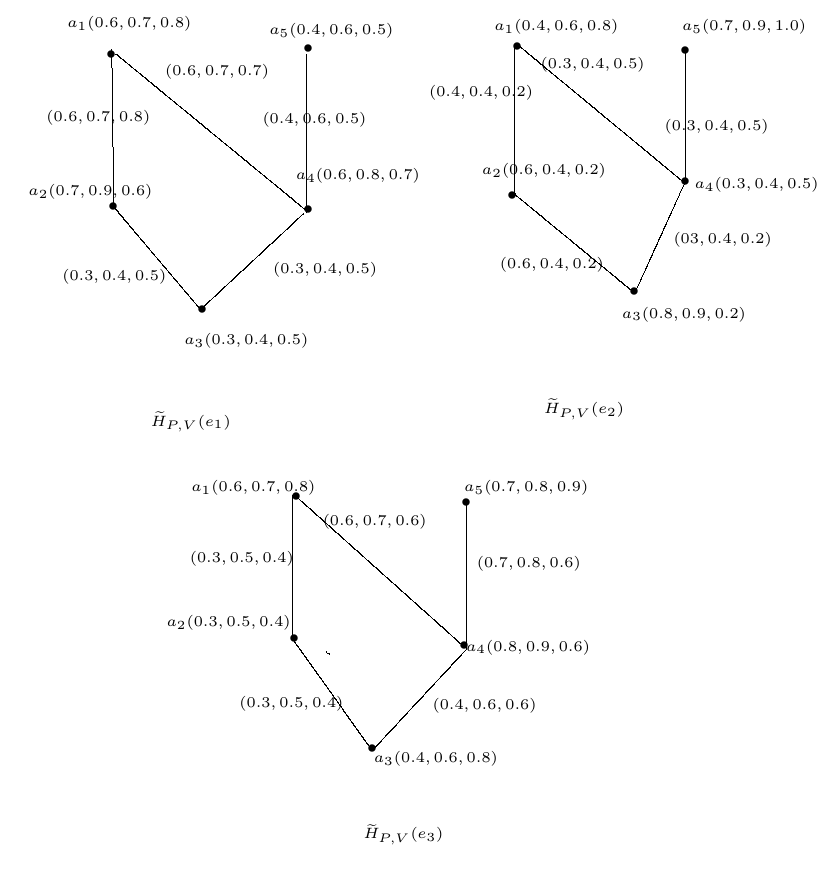
Figure.4. Independent set of a